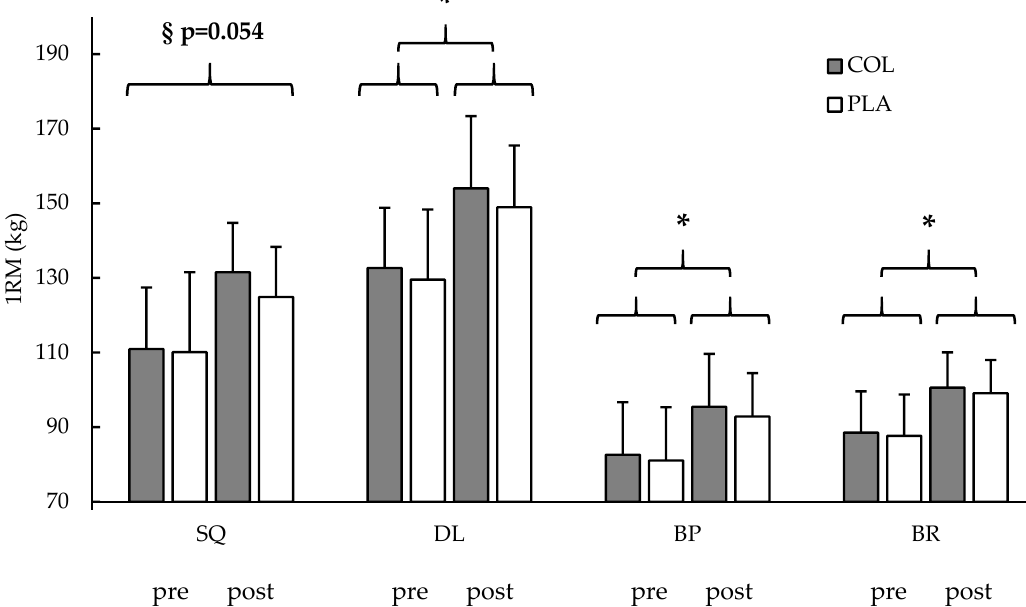
Figure 2. Dynamic maximal strength (1RM) before (pre) and after (post) a 12-week training period with a collagen peptide (COL, gray blocks) or a placebo (PLA, white blocks) supplementation. SQ = squat; DL = deadlift; BP = bench press; BR = bent-over row. § = trend for an interaction effect (time × group: p = 0.054); * = significant main effect (time: p < 0.05). Values are means ± SD.